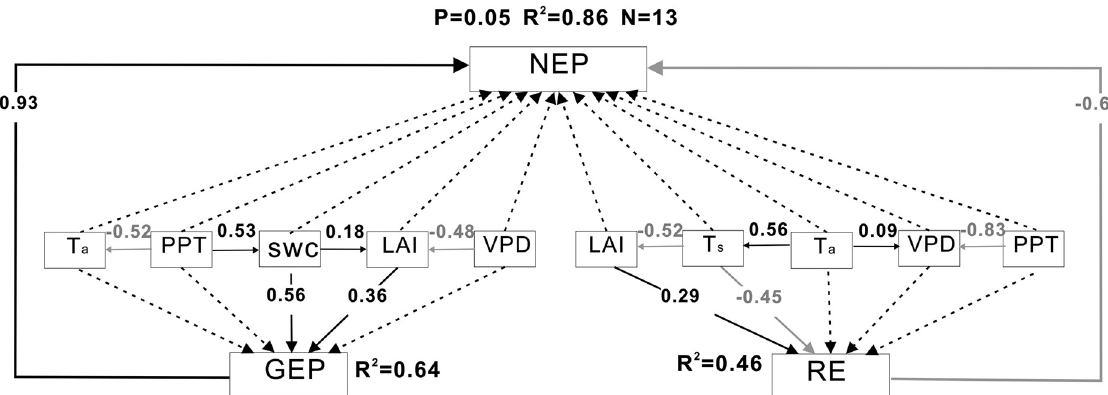
Fig 3. Results of the structural equation modeling (SEM) of the relationships among annual anomalies of climatic and biotic variables, gross ecosystem productivity (GEP), ecosystem respiration (RE), and net ecosystem production (NEP). Black arrows indicate significant positive relationships while gray arrows indicate significant negative relationships (P < 0.05). Black dashed arrows indicate insignificant relationships (P > 0.05). Numbers adjacent to arrows are path coefficients indicating the effect size for the relationship. The proportion of variance explained is given by R 2